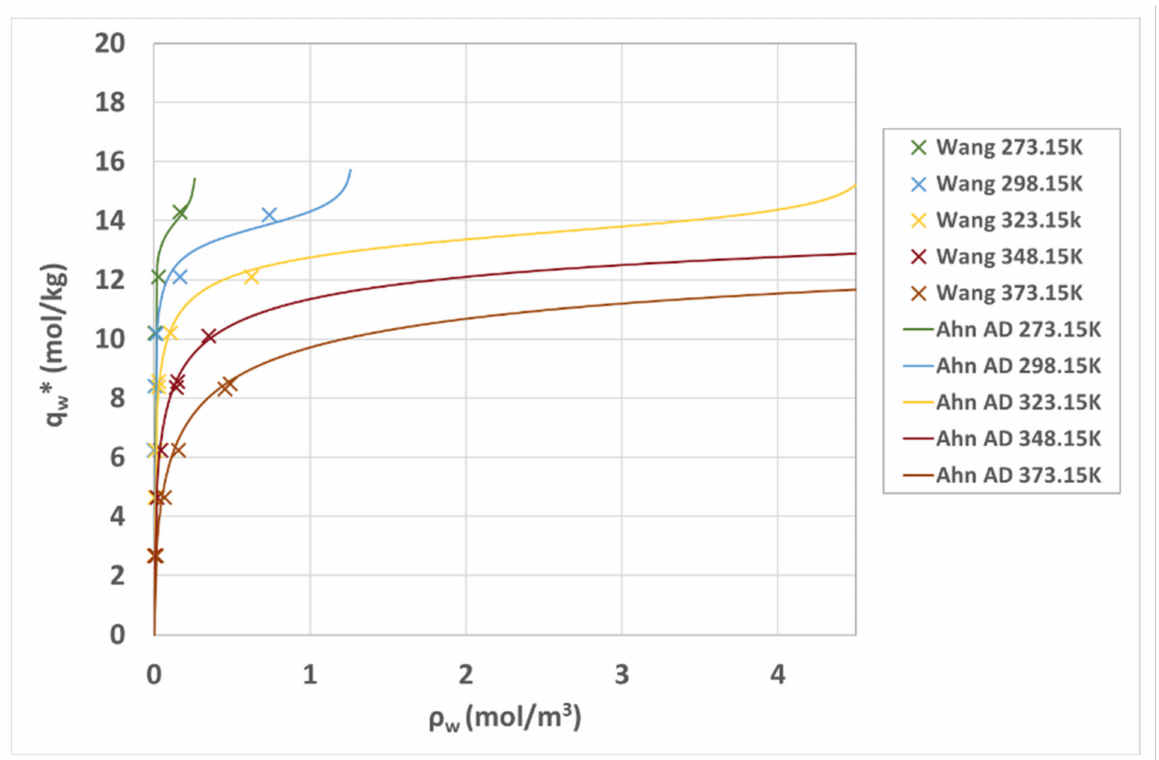
Figure 3. Adsorption isotherms of water/Z13X at different temperatures from Wang [46] x and corresponding applied isotherm model recovered from Ahn [48] lined curve.